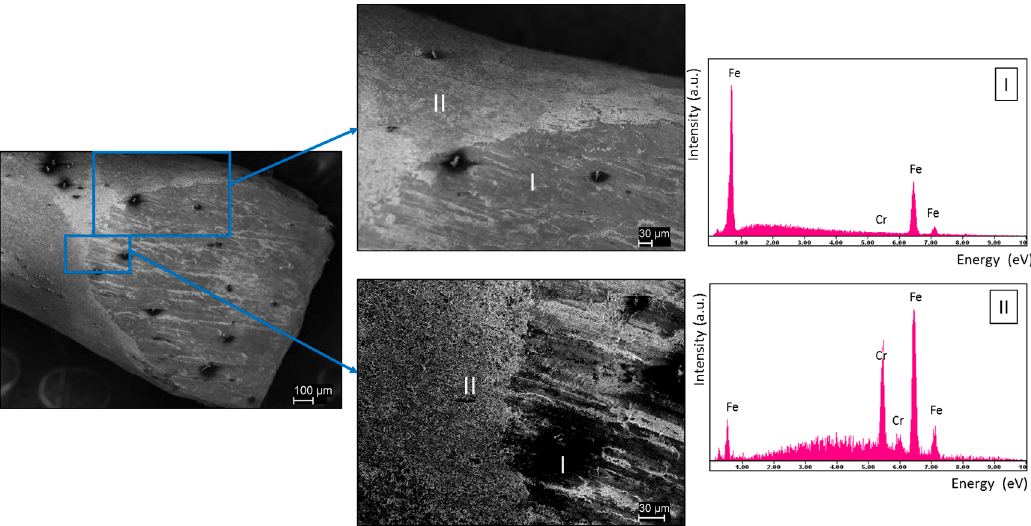
Figure 5. SEM Examination of Coated Iron Wire Prepared with Chrome Nitrate. SEM: This sample was prepared with only a single dip procedure. The surface layer is visibly distinct from the cut iron cross section. The surface layer appears to be composed of micron scale sections of chrome and is probably porous. EDAX: This analysis shows the surface is dominated by chrome and in the interior of the wire only iron is observed.